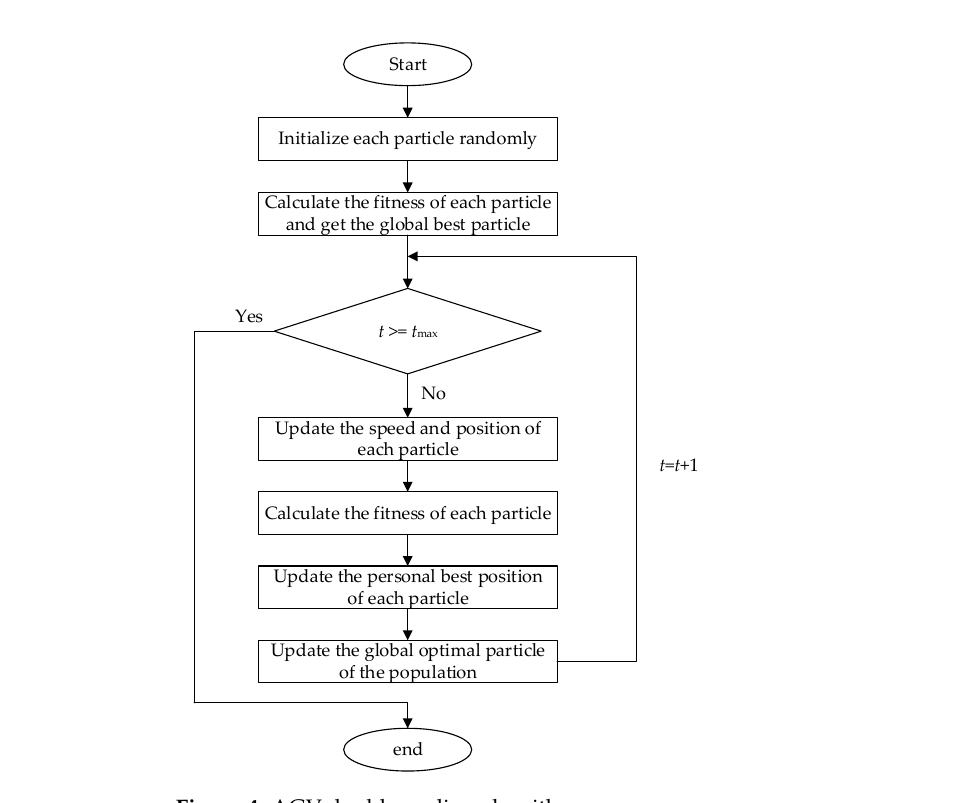
Table 5. The data obtained in Qingdao